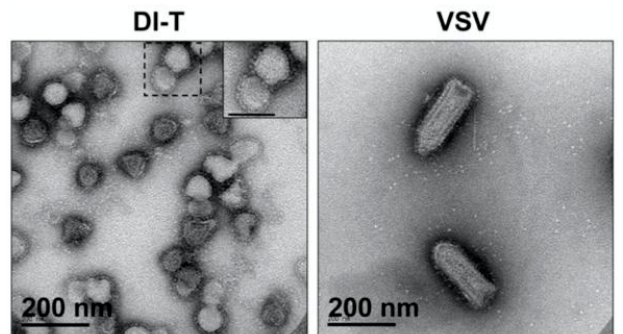
Figure 1. Transmission electron microscopy images of vesicular stomatitis virus defective interfering (DI-T) and standard (VSV) particles. DI-T particles are truncated relative to full-length VSV particles. Image adapted from [31].